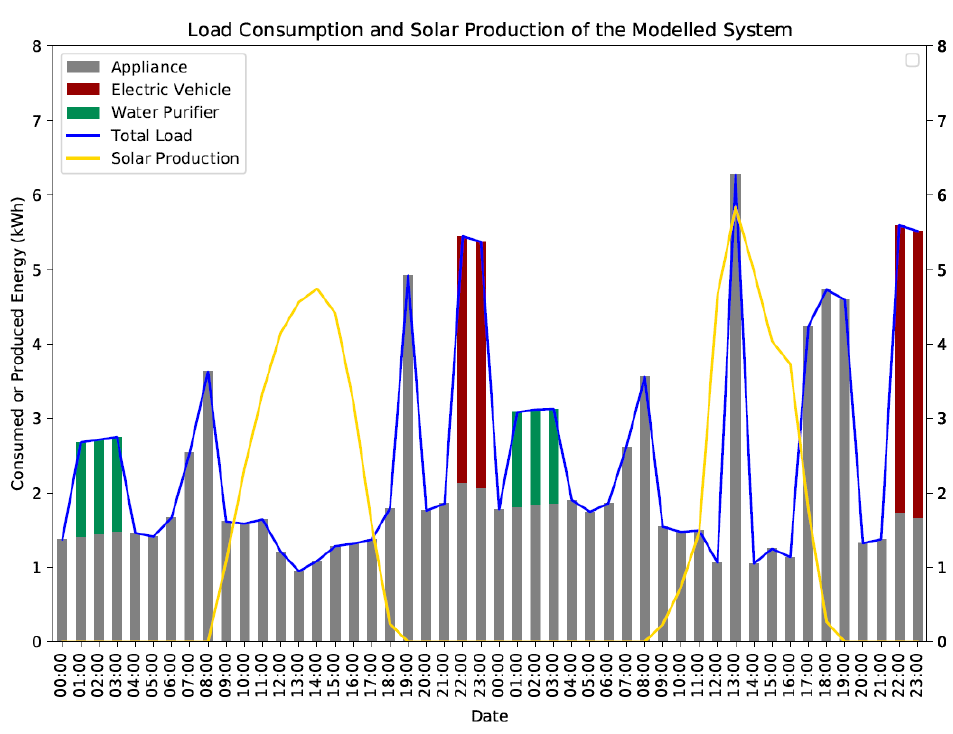
Figure 9. Proposed load scheduling operation.